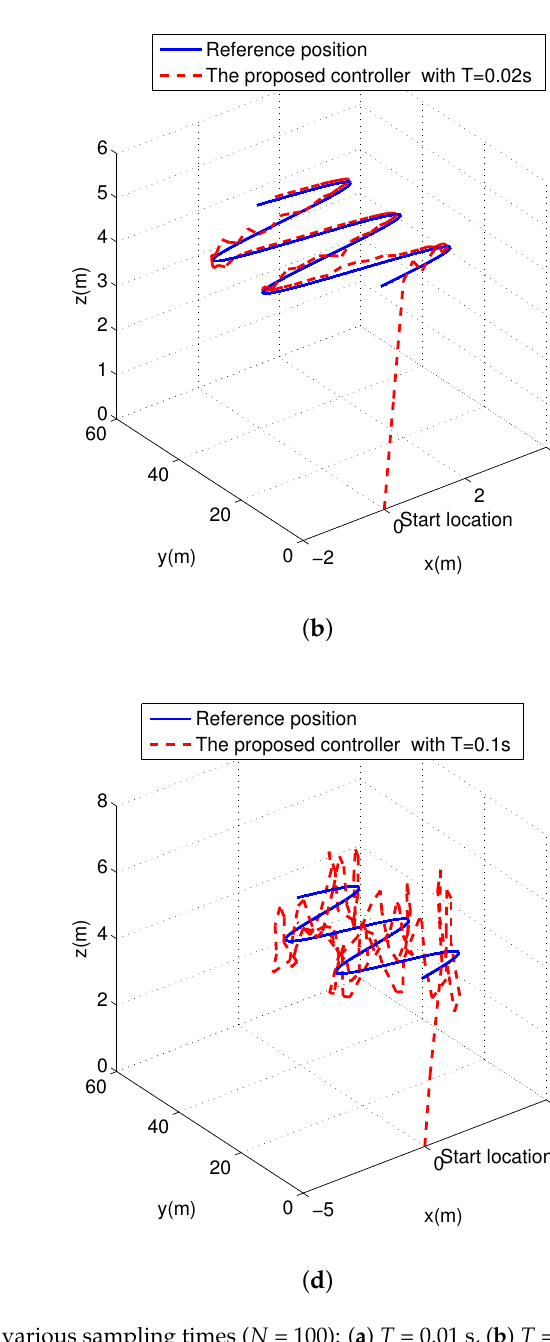
Figure 5. AUV 3D position tracking for noise case 1 under various sampling times ( N = 100): ( a ) T = 0.01 s, ( b ) T = 0.02 s, ( c ) T = 0.05 s, and ( d ) T = 0.1